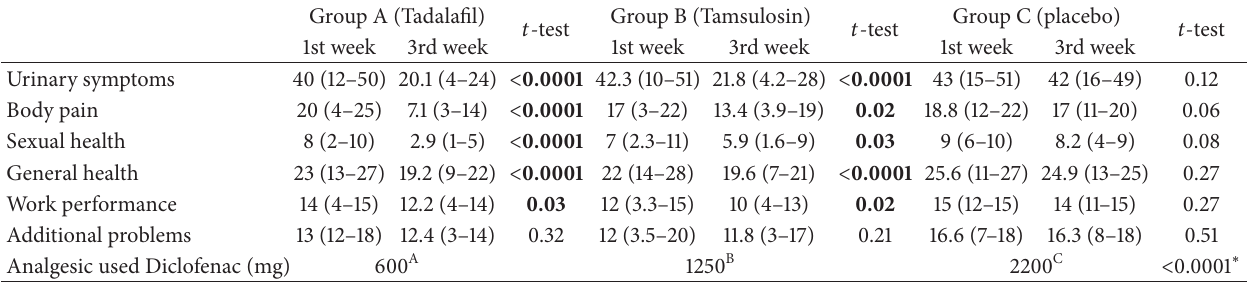
Table 2: Ureteral stent symptom score at 1st week and 3rd week in three groups.